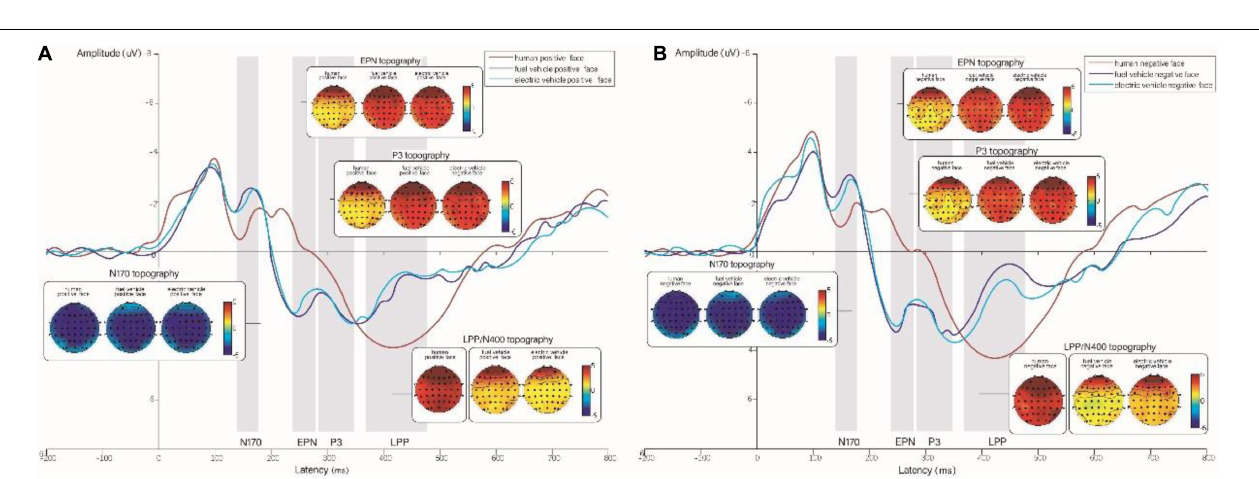
FIGURE 4 | (A) Grand-averaged event-related potentials (ERPs) for positive expressions on human, gasoline vehicle, and electric vehicle faces recorded in the electrodes of the frontal, and topographic maps corresponding to the experimental conditions. (B) Grand-averaged ERPs for negative expressions on human, gasoline vehicle, and electric vehicle faces recorded in the electrodes of the frontal region and topographic maps corresponding to the experimental conditions. The red line represents human faces; the purple line represents gasoline vehicle faces; the blue line represents electric vehicle faces.